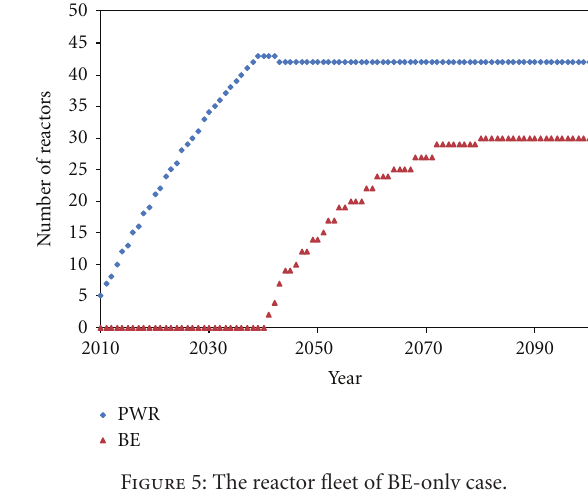
Figure 5: The reactor fleet of BE-only case.